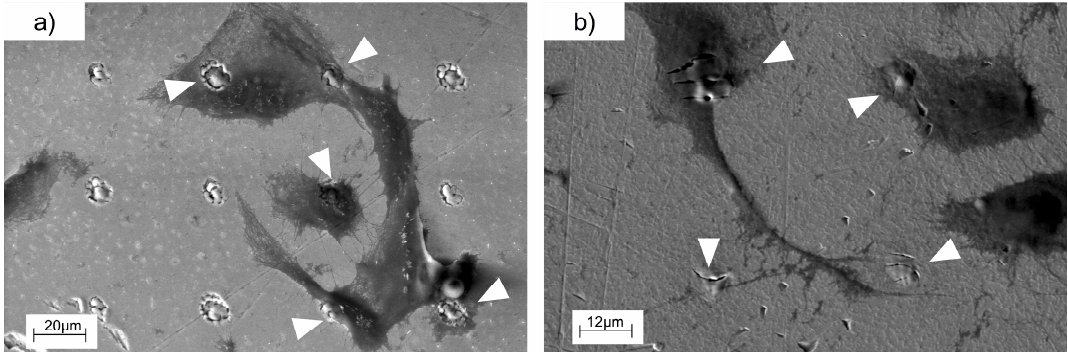
Figure 11. SEM images of the pattern of 45 μ m on both ( a ) titanium and ( b ) tantalum where the cell guiding is shown. Arrowheads indicate the microholes fabricated that act as anchor points for cells.